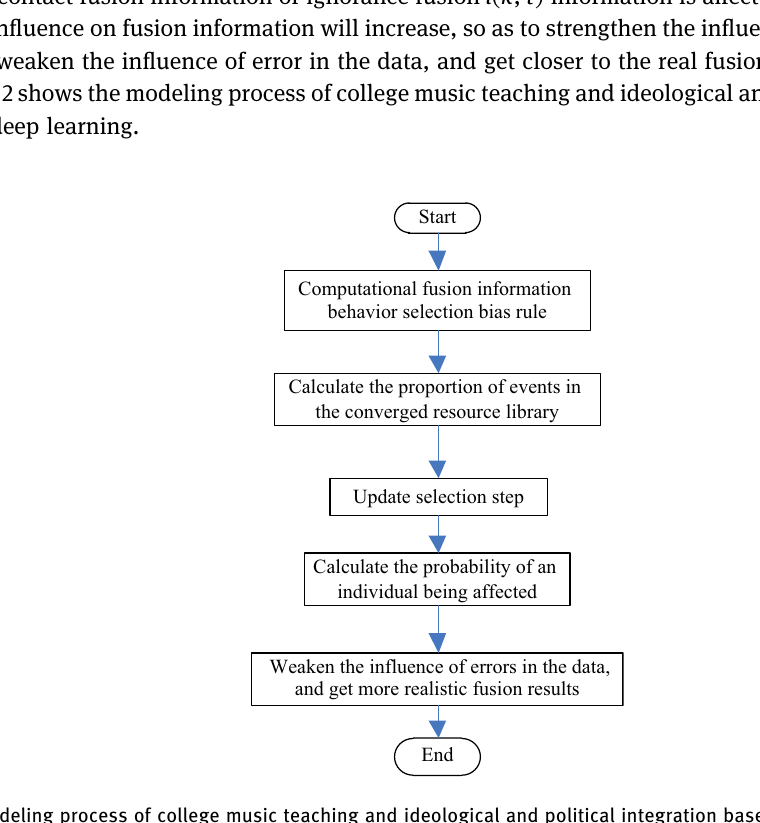
Figure 2: Modeling process of college music teaching and ideological and political integration based on deep